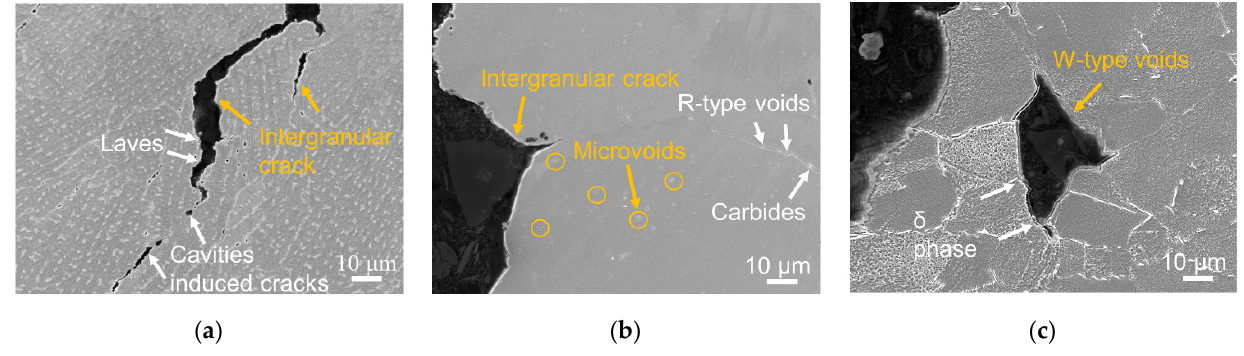
Figure 6. Ruptured creep specimens at 650 °C/700 MPa: ( a ) DA, ( b ) HIP-DA, ( c ) Wrought.